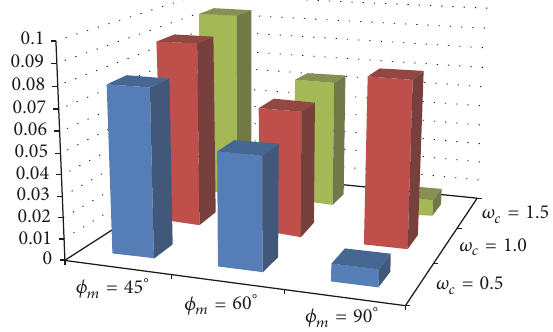
Figure 16: ITAE indices values of 𝑃 1 (𝑠) .